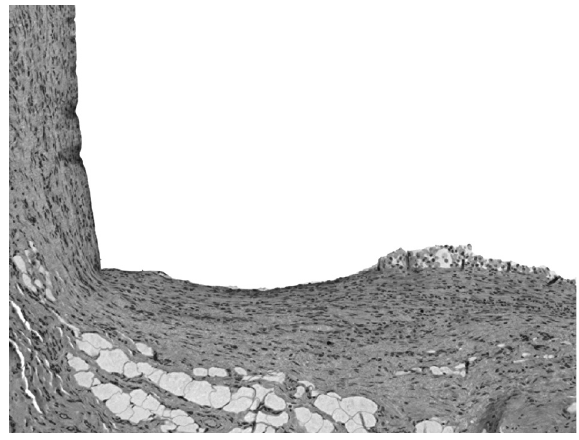
Figure 1. Inflammatory response in non-diabetic Control group at day 30: specimens showing thin fibrous capsule formation and mild inflammatory cell infiltration consisting of macrophages and lymphocytes (hematoxylin-eosin, 10X).